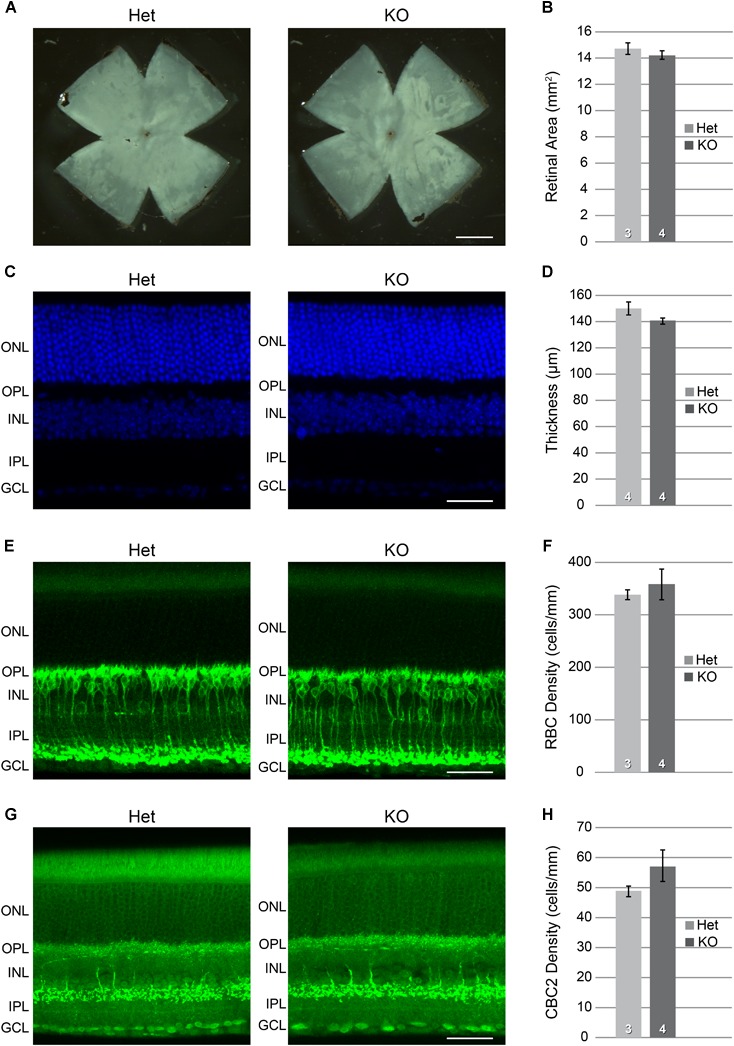
Xkr8 KO versus heterozygous (Het) mice showed no difference in their total retinal area (A,B), nor in the total thickness of the retina (C,D). Individual retinal layers also did not differ (not shown). The densities of RBCs (E,F) and CBC2s (G,H) were slightly, though not significantly greater in the KO retinas (p > 0.1). n = the number of retinas examined in each condition. Scale bar = 1 mm for (A); = 100 μm for (C,E,G).